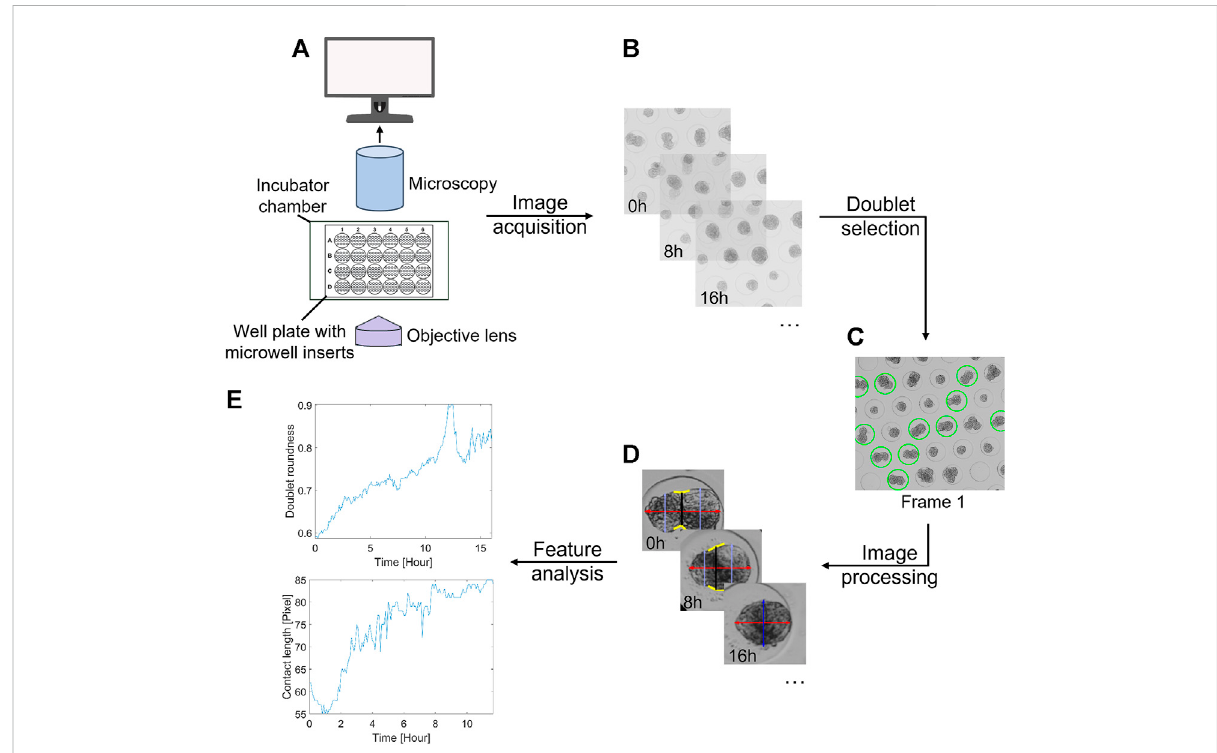
FIGURE 1 Generaloverviewoftheproposedmethodology. (A) Imagingsetup,consistingofabright- fi eldmicroscopewithanautomatedstage,TopStage incubator, cellSens imaging software, and a 24-well plate with agarose inserts. (B) Acquisition of time-lapse data sets. (C) Manual or semi-automatic doubletselectionbasedonthe fi rstframe. (D) Extractionofseveralmorphologicalfeaturesovertimethroughimageanalysis. (E) Timeseriesanalysis. As an example, the doublet roundness and contact length are